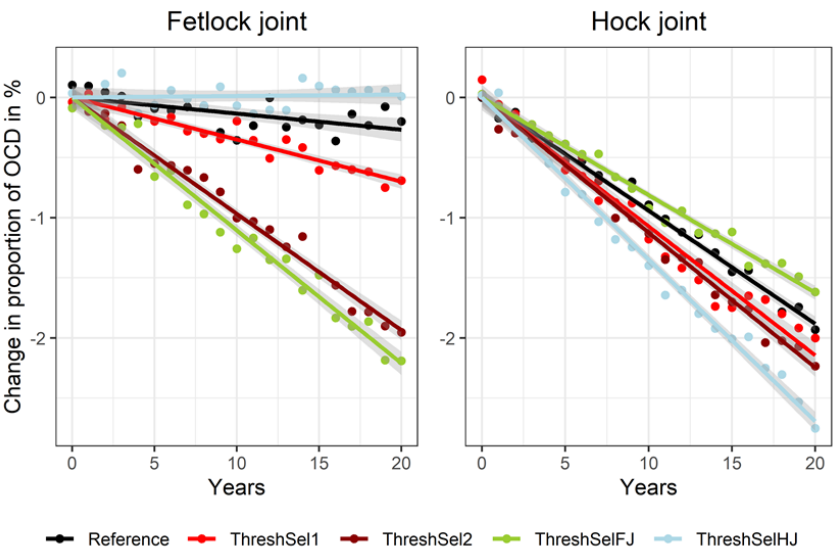
Figure 2. Proportion of unselected offspring with OCD in fetlock joints and hock joints for a reference scenario and for four different scenarios using threshold selection against OCD.